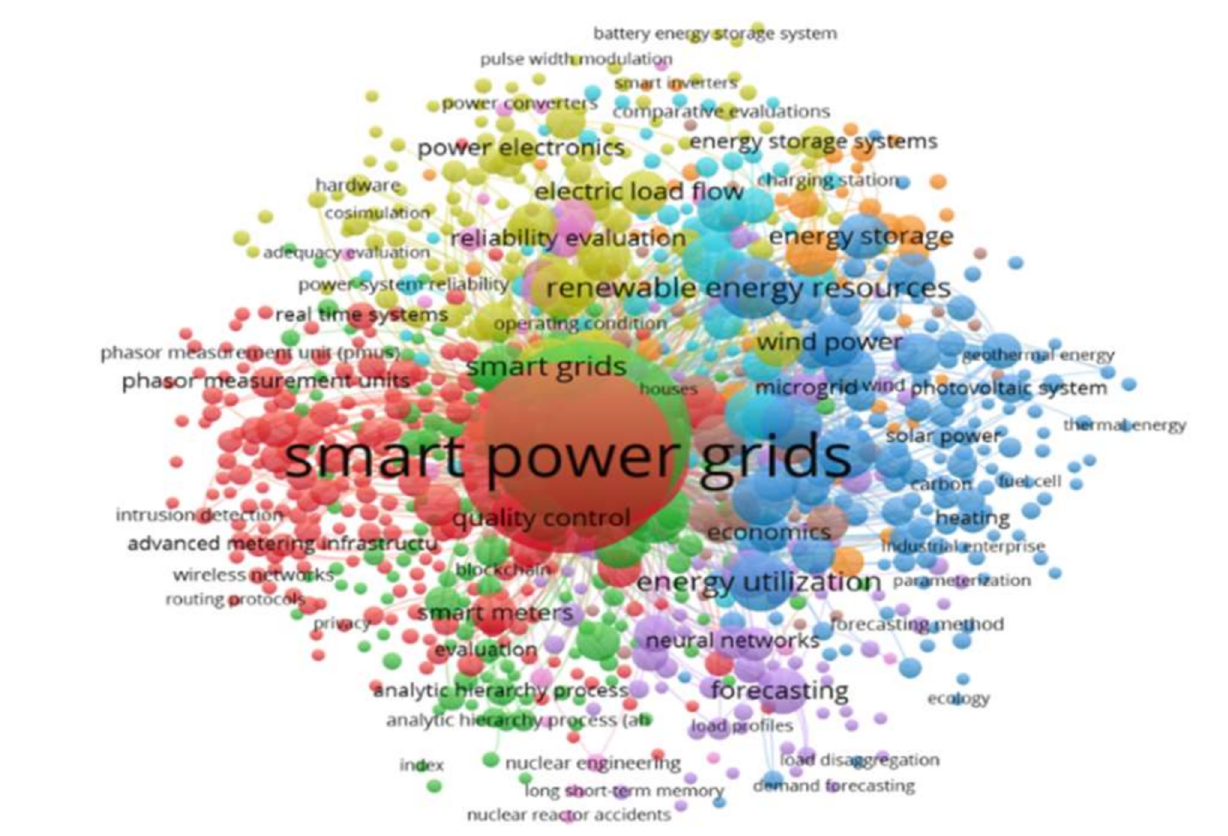
Figure 2. Results of the bibliometric analysis in the area of smart grids assessment. At the heart of the fourth (yellow) cluster is the concept “smart grids”